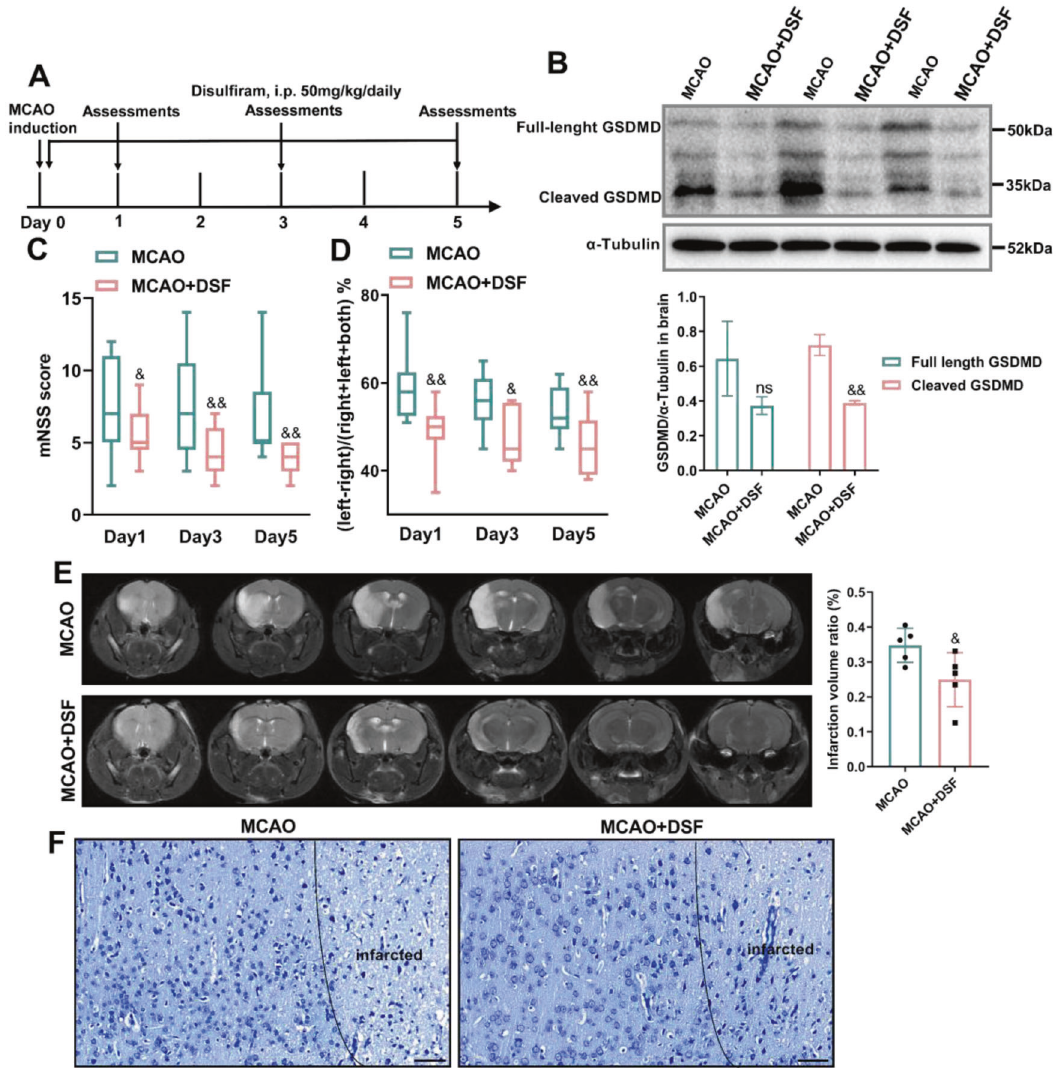
Fig. 6 Pharmacological inhibition of GSDMD ameliorates stroke-induced brain de fi cits. A Flowchart showing disul fi ram administration and the experimental design. Mice received daily intraperitoneal (i.p.) injections of disul fi ram (50 mg/kg) or equivalent amounts of phosphate- buffered saline (PBS) 30 min after MCAO surgery and for 5 consecutive days after MCAO. B Western blot analysis of GSDMD protein expression in the brain tissue of disul fi ram-treated mice compared with mice in the PBS group ( n = 3). C , D Neurobehavioral tests, including the mNSS ( n = 13 – 17) and cylinder test ( n = 13), day 1, day 3 and day 5 after MCAO. E Representative magnetic resonance imaging and quantitative analysis of infarcted brains on day 3 after stroke in disul fi ram-administered mice compared with PBS group ( n = 5); the infarct area is shown in white. F Representative Nissl staining images of the cortex in each group. Scale bars, 50 μ m. The data are presented as the mean ± SD. Statistical analysis: multiple two-tailed unpaired Student ’ s t test ( B – D ) or unpaired two-tailed Student ’ s t test ( E ). ns not signi fi cant, & P < 0.05, && P < 0.01 vs WT mice after MCAO. DSF disul fi